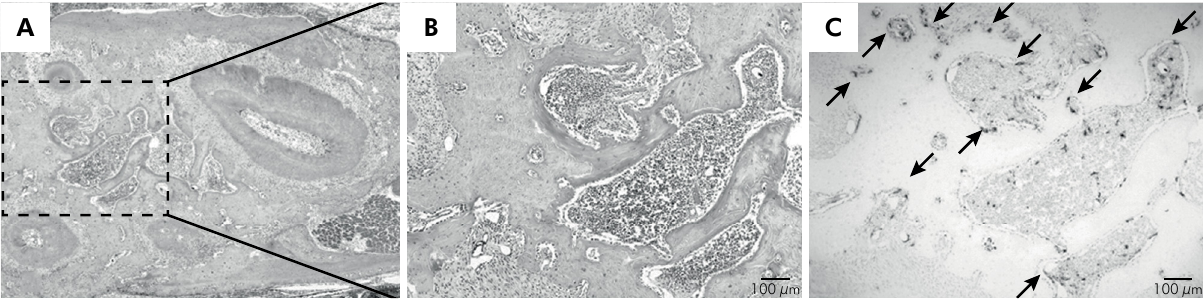
Figure 4. TRAP-positive osteoclasts in the 0.5 mm displacement group at 1 week after segmental osteotomy on the maxillary first molar. A: T.S. at the root region of the maxillary first molar. B: Magnified view of the dotted box in A (1 x 1 mm 2 area between the roots of the maxillary first molar). C: TRAP-positive cells were counted within this dotted box.